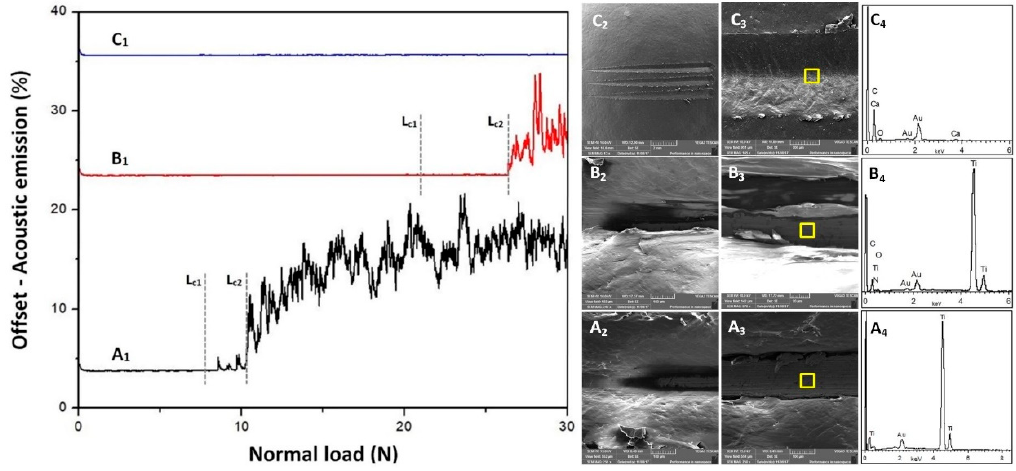
Figure 14. Acoustic emission with respect to the applied normal load from 0 to 30 N and SEM image of scratch with EDX analysis for (A1/A2/A3/A4) Pristine UHMWPE (B1/B2/B3/B4) U1.5C (C1/C2/C3/C4) U1.5C3H.